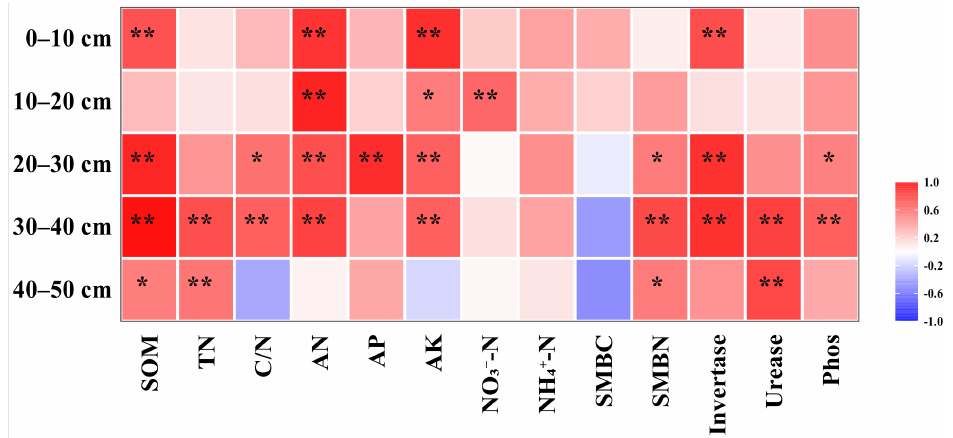
Figure 6. Plot of correlation coefficients between soil nutrient content and EMF indexes. * represents p < 0.05; ** represents p <